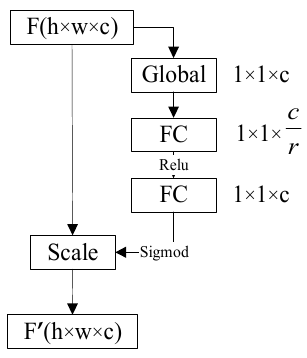
Figure 5. Channel attention based on a squeeze-and-excitation module.